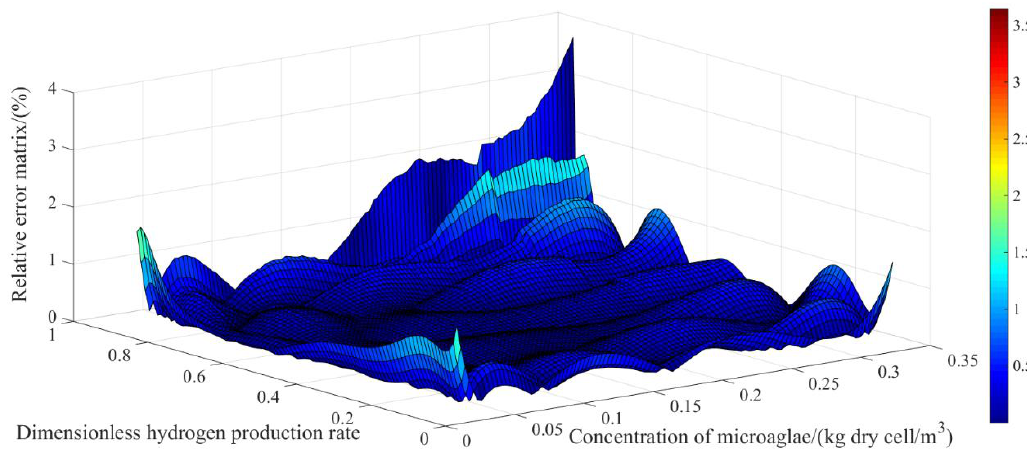
Figure A6. The relative error matrix about Figure 11.